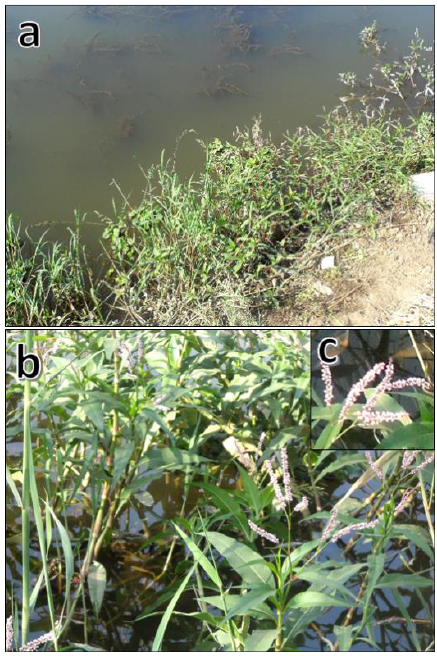
Figure 1. Persicaria lapathifolia (L.) Delarbre: ( a ) overview of the aerial parts growing on the canal bank habitat, ( b ) close view of the aerial parts, and ( c ) close view of the inflorescence. Persicaria lapathifolia is an annual herb that grows up to 80 cm and has reddish stems and alternate leaves [17]. This plant has grown worldwide (cosmopolitan) and inhabits various moist habitats and in agricultural fields. This species is considered a troublesome weed. Persicaria lapathifolia has many uses in traditional medicine such as antibacterial, antiviral, anti-inflammatory, astringent, antiseptic, anti-stomach complaint, hepatoprotec- tive, and antifungal uses in addition to its use for the treatment of dysentery, burns, and fevers [20]. Several studies have revealed that different extracts and isolated